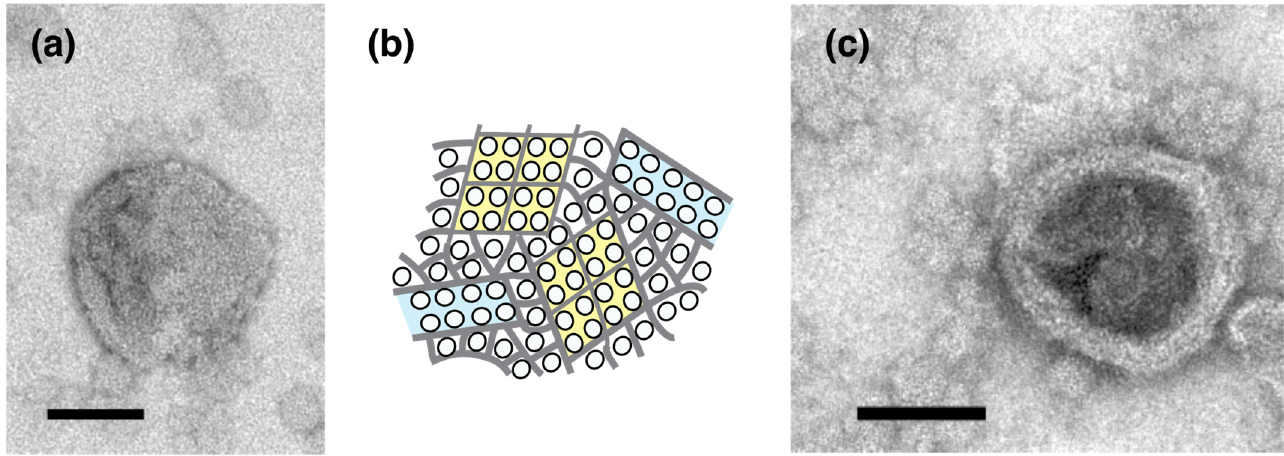
Figure 5. Typical images of the crystal patch assembly and unclear dispositions of the 40 Å particles. ( a ) vesicle containing crystal patch assembly. ( b ) Illustration of the crystal patch assembly. ( c ) Unclear disposition. SR vesicles were incubated at 0.026 ( a ) and 0.11 ( c ) µM Ca 2+ in the absence of ATP for 1 min. Scale bar:100 nm.